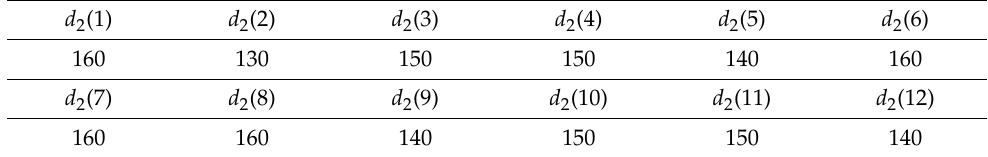
Table 8. Economical production plan.